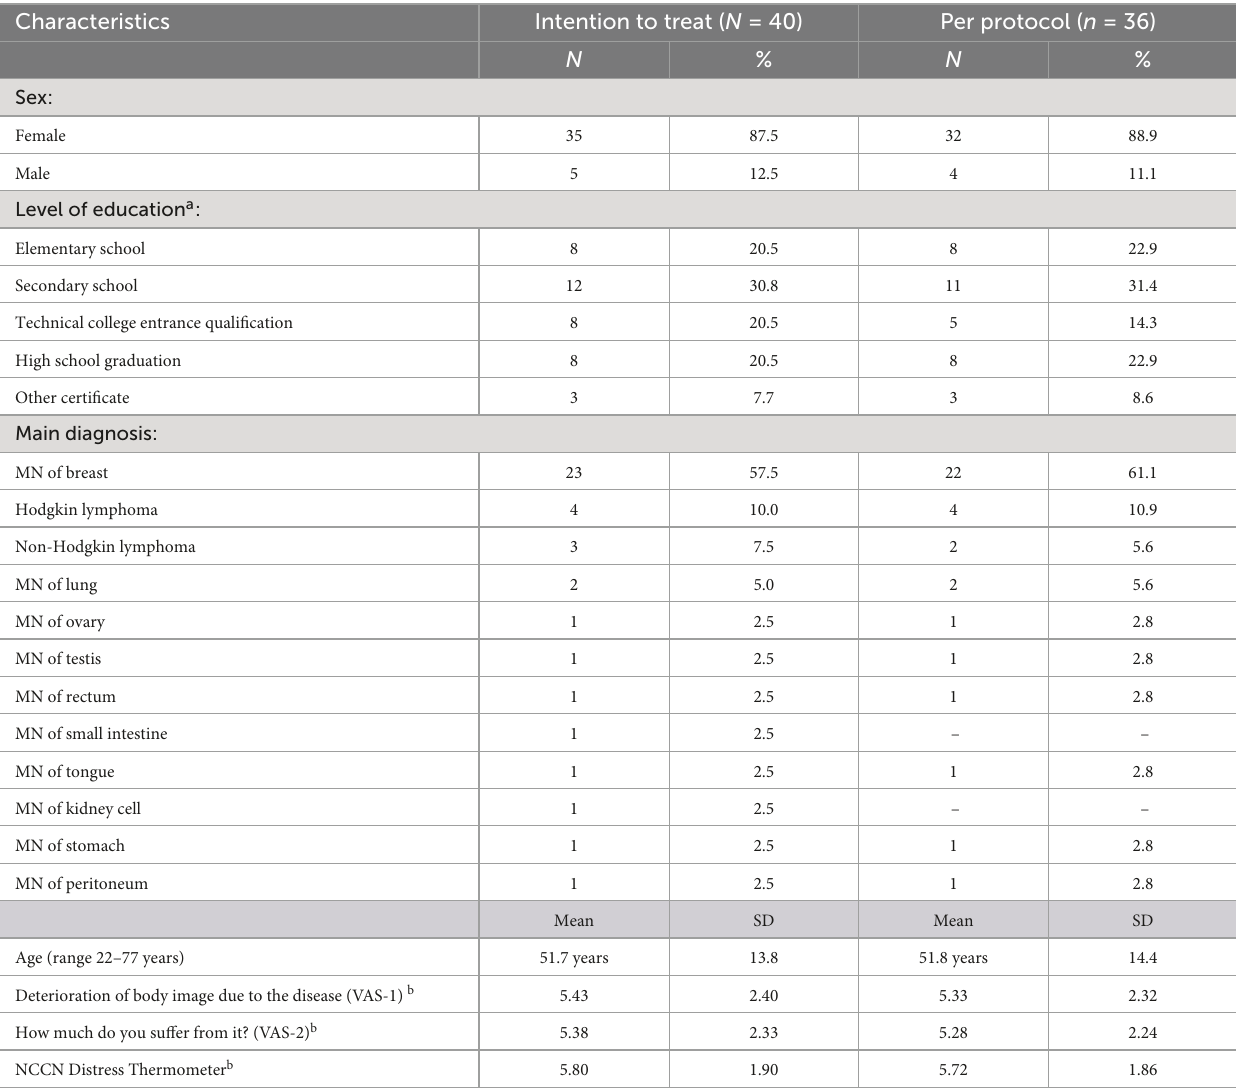
TABLE 1 Sample characteristics.